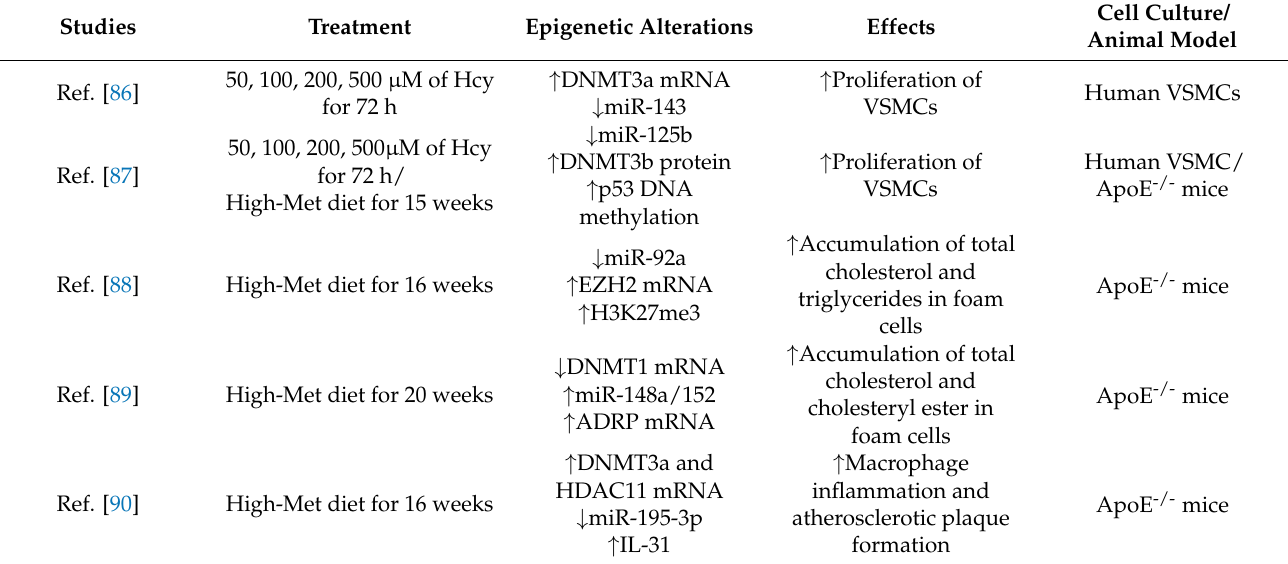
Table 1. Effects of HHcy and miRNAs in HHcy-related atherosclerosis